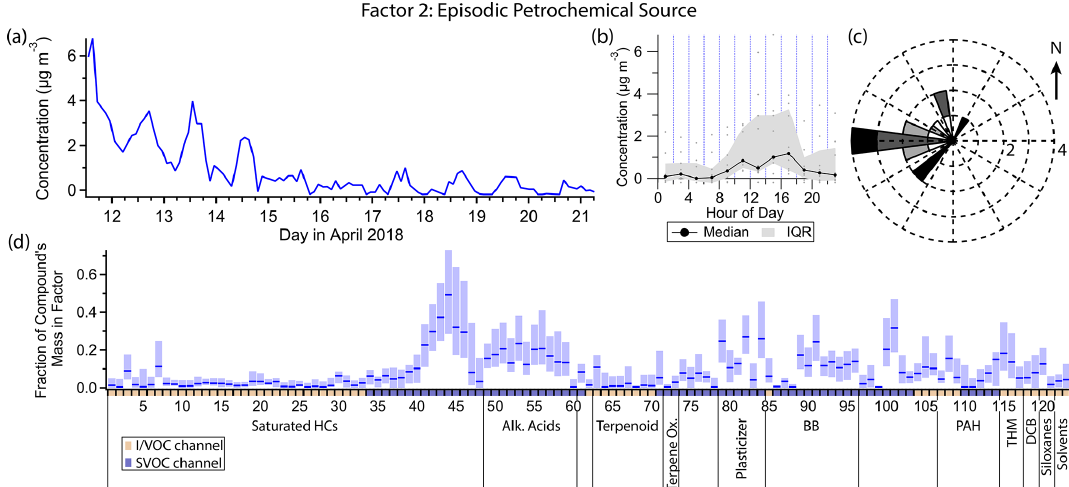
Figure 5. (a) Factor 2 timeline. (b) Diurnal profile for Factor 2. (c) Rose plot showing correlation of elevated emissions and wind direction. (d) Factor 2 composition profile. See Fig. 4 description for further information on how to read this figure.